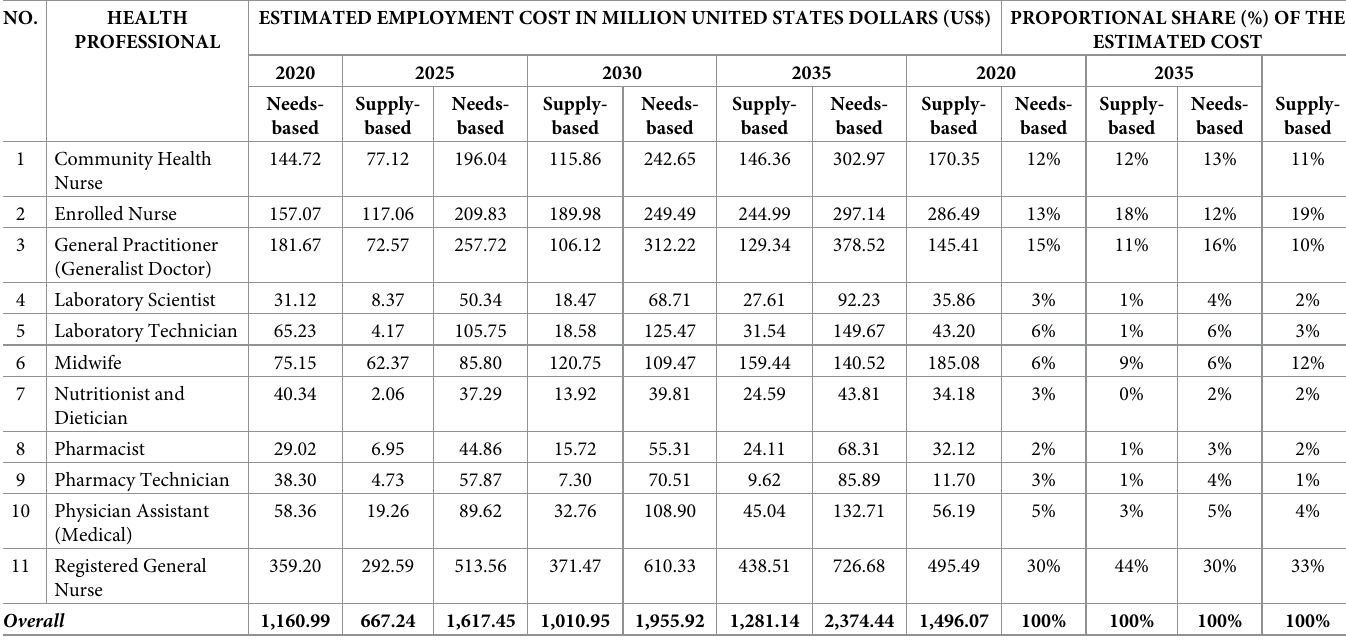
Table 6. Investments required for employment: Anticipated supply versus needs-based requirement of health professionals, 2020–2035.